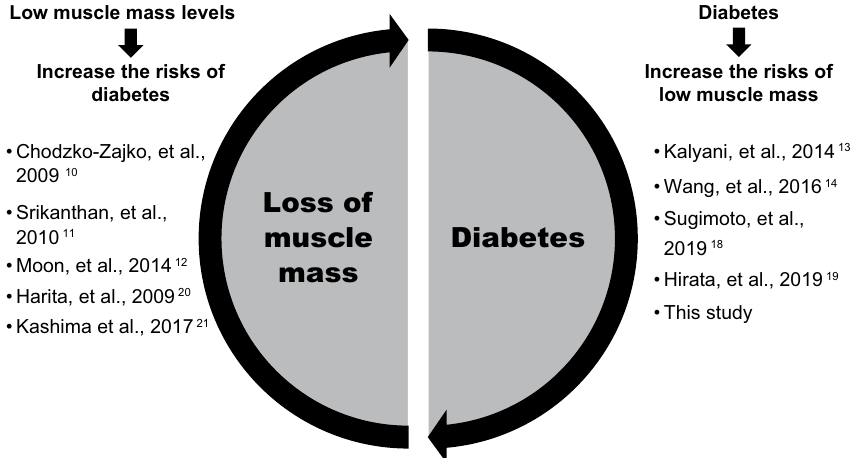
Figure 4. The bidirectional interactions between diabetes and loss of muscle mass with ageing